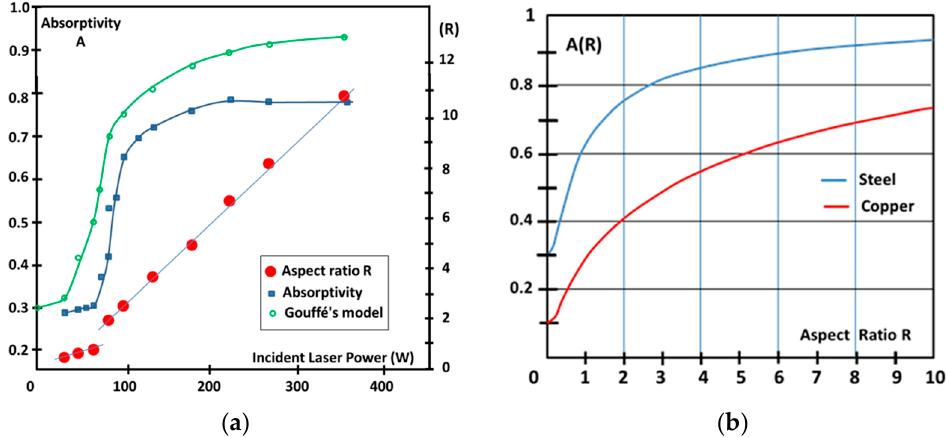
Figure 8. ( a ) From Trapp et al. [30]: time integrated absorptivity of 316l SS steel as a function of incident power for a welding speed V w = 0.5 m/s (blue squares); corresponding measured aspect ratios R = e/d 0.5 (d 0.5 ≈ 40 µm) (red dots). For each aspect ratio, the resulting absorptivity from the Gouffé’s model for a conical geometry has been reported (green dots). ( b ) Examples of absorptivity from the Gouffé’s model for a conical geometry (for steel, with A 0 ≈ 0.31) and copper, with A 0 ≈ 0.1).